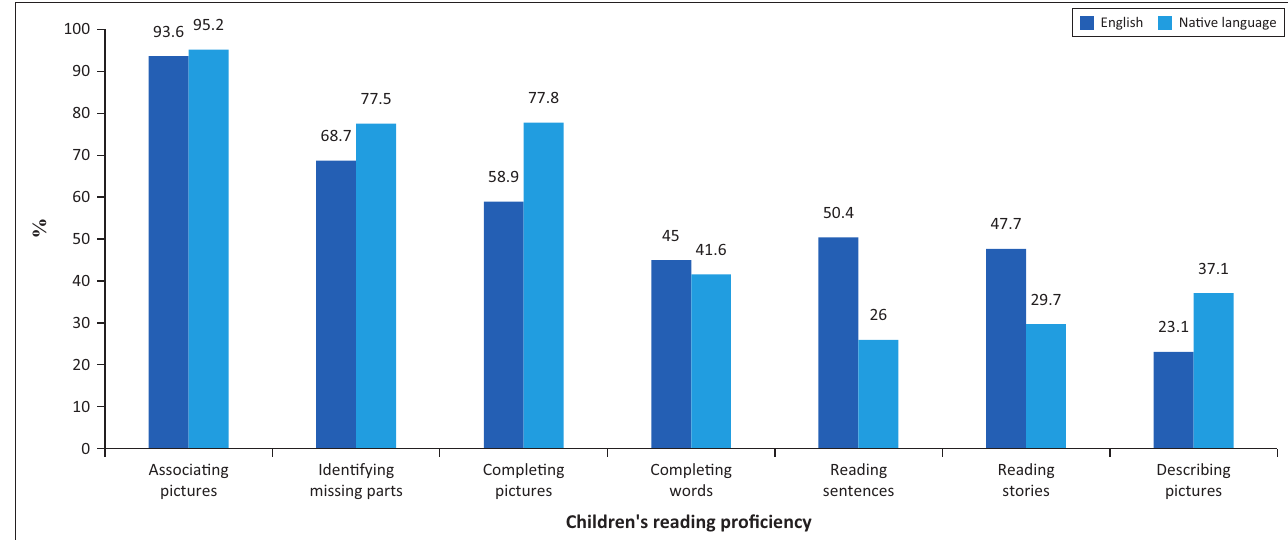
FIGURE 1: Children’s proficiency in reading comprehension in English and native